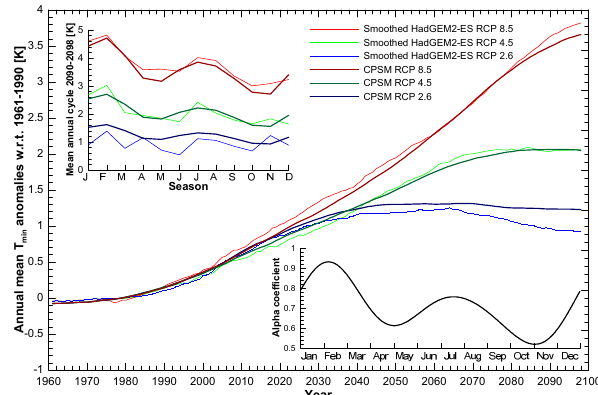
Fig. 4. Annual mean T 0 min smoothed time series at Alexandra, New Zealand (45.2 ◦ S, 169.4 ◦ E) from a HadGEM2-ES simulation based on RCP 4.5 emissions (light green), together with its regression model fit (dark green). The α fit-coefficients, resolved by season, are shown in the lower right inset. When these fit- coefficients are used together with the T 0 global predictor time series from HadGEM2-ES simulations under the RCP2.6andRCP8.5scenariostheyproducethedarkredanddarkbluecurves,respectively. Theactualannual mean RCP 2.6 and RCP 8.5 smoothed T 0 min time series at 45.2 ◦ S, 169.4 ◦ E are shown as light blue and light red lines, respectively. The insert in the upper left shows the mean annual cycle, calculated from the monthly T 0 min timeseries,from2090to2098forallsixtimeseries.